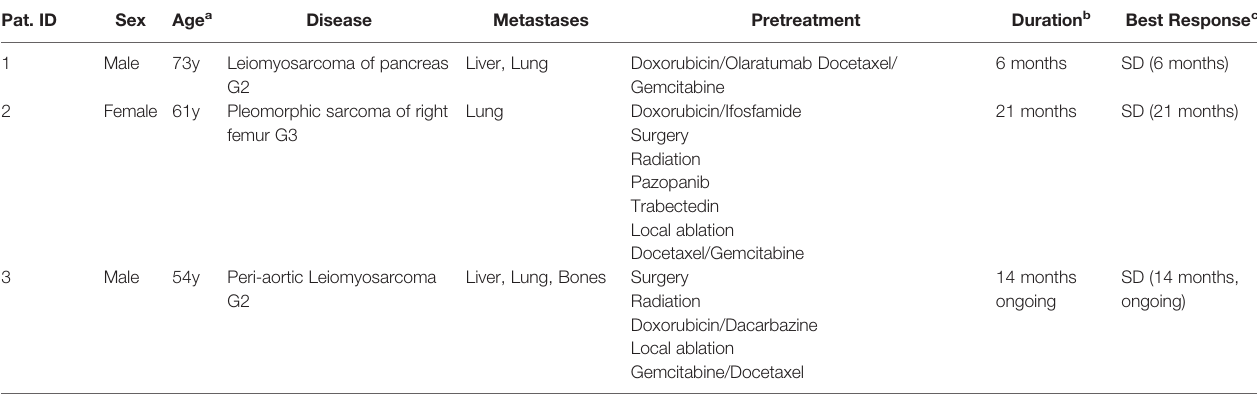
TABLE 2 | Patient characteristics and response to Gemcitabine maintenance therapy. Pat. ID